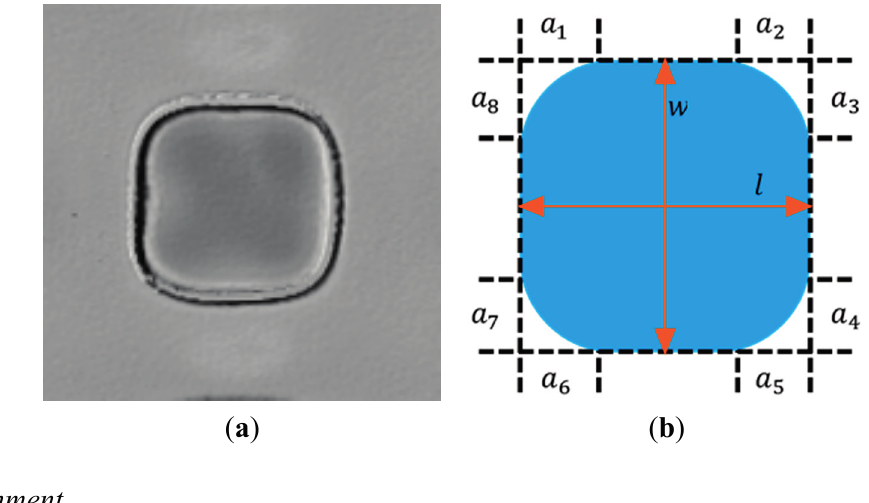
a shaped single laser